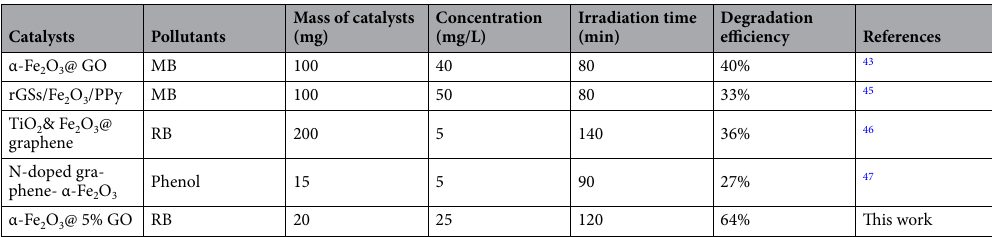
Table 3. comparison of photocatalytic performance of α-Fe 2 O 3 @ 5% GO powder nano composite with other reported nanomaterials.